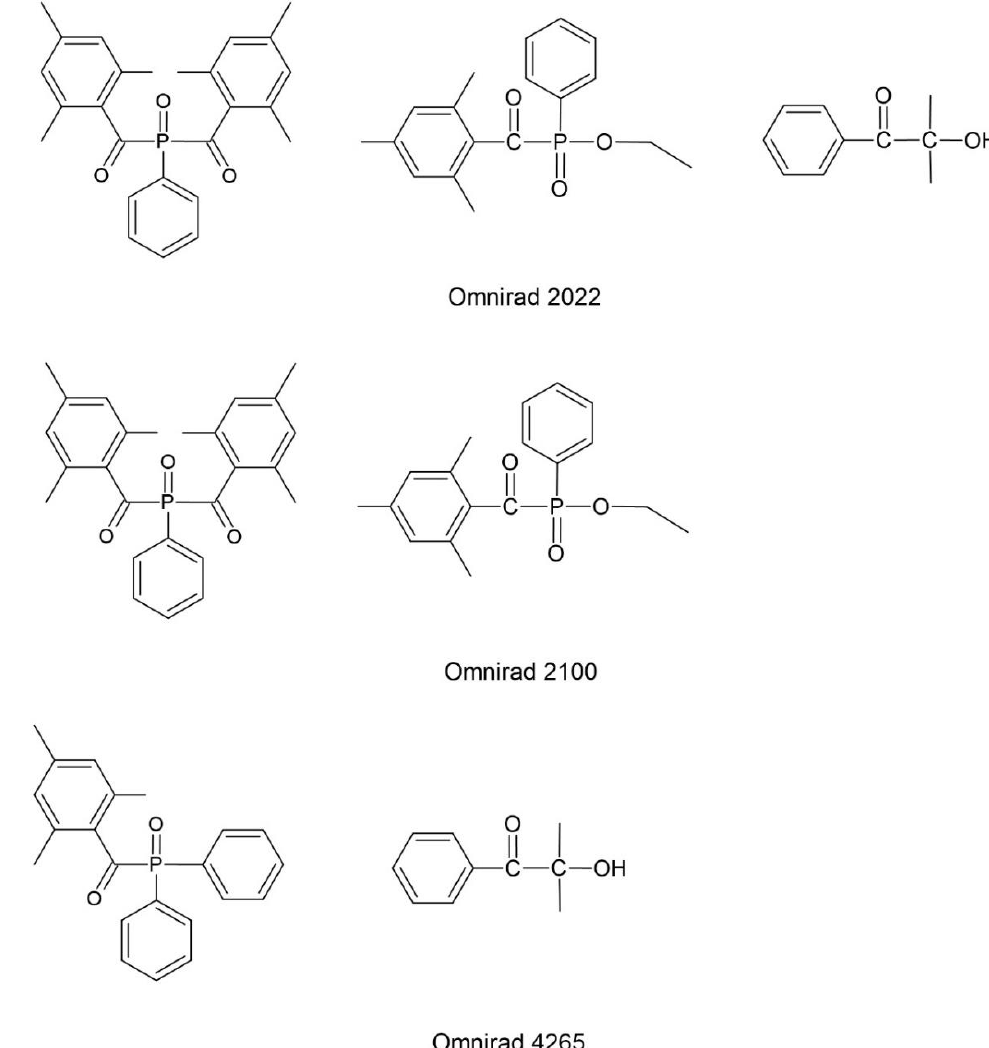
Figure 5. Structure of the free-radical photoinitiators–mixtures.